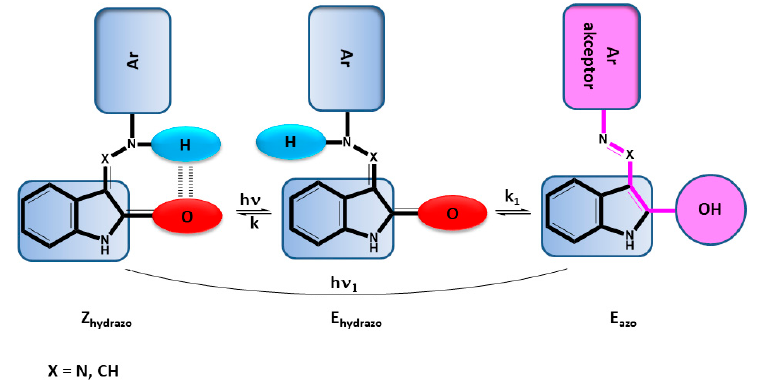
Scheme 8. Schematic representation of studied compounds ON/OFF functionality.